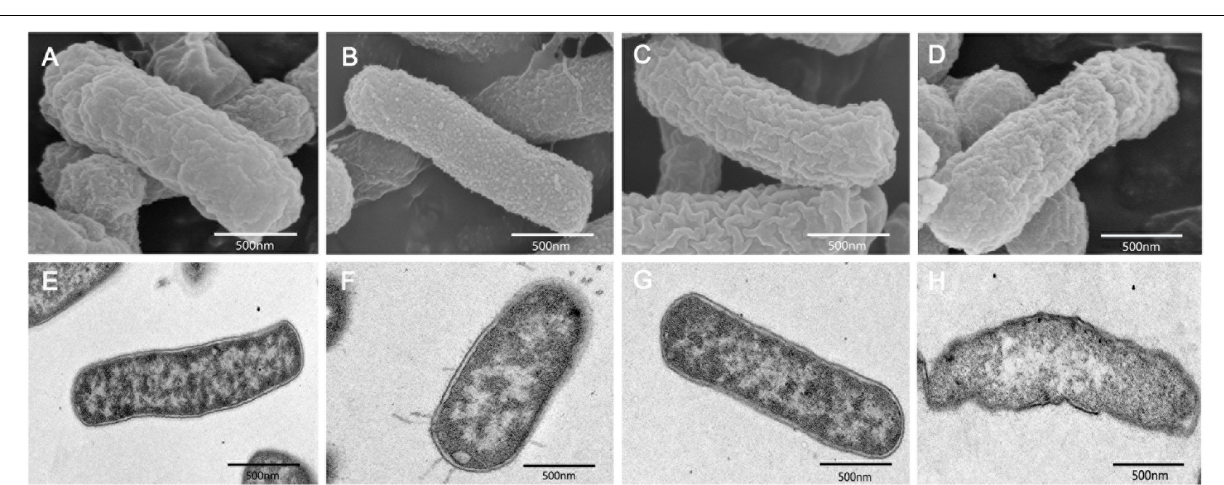
FIGURE 3 | SEM and TEM images of high-level Col-R K. pneumoniae 18605 after treatment with 2 mg/L colistin alone (B,F) , 2 mg/L auranofin alone (C,G) , or combination (D,H) for 2 h. (A,E) represent the control